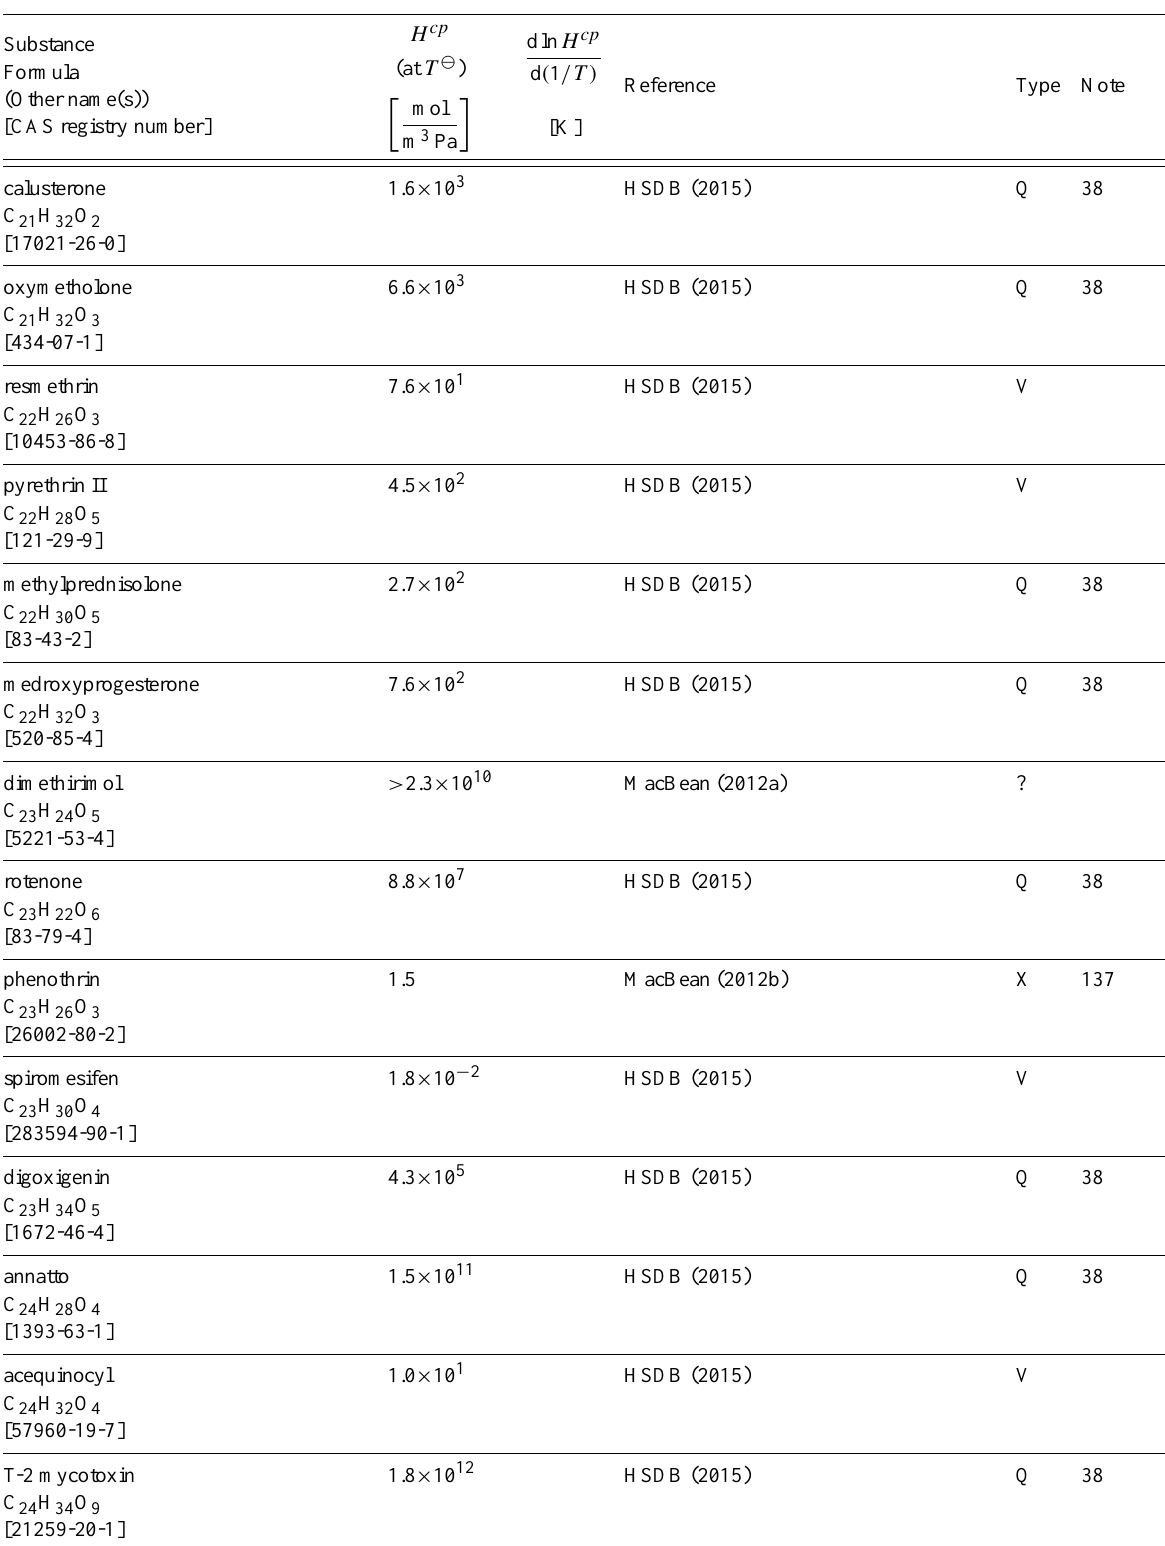
Table 6: Henry’s law constants for water as solvent